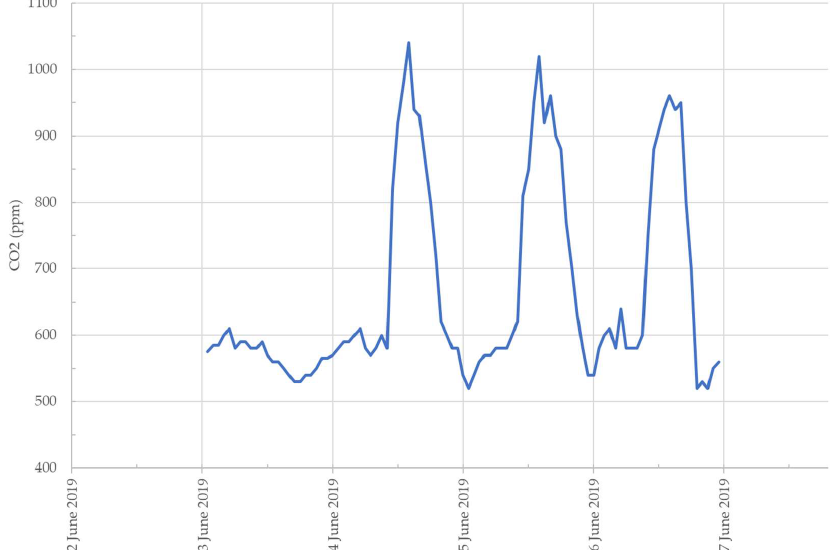
Figure 10. Trend of CO 2 values (ppm) for the period from 3 to 6 June 2019 detected by the continuous monitoring system in Room 160 owned by the museum.